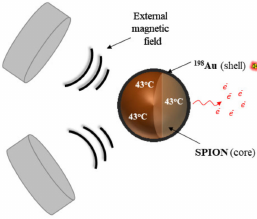
Figure 1. Investigated concept of application of SPIONs coated with a 198 Au layer for simultane- ous treatment of HCC by β − radiation emitted by 198 Au and magnetic hyperthermia generated on